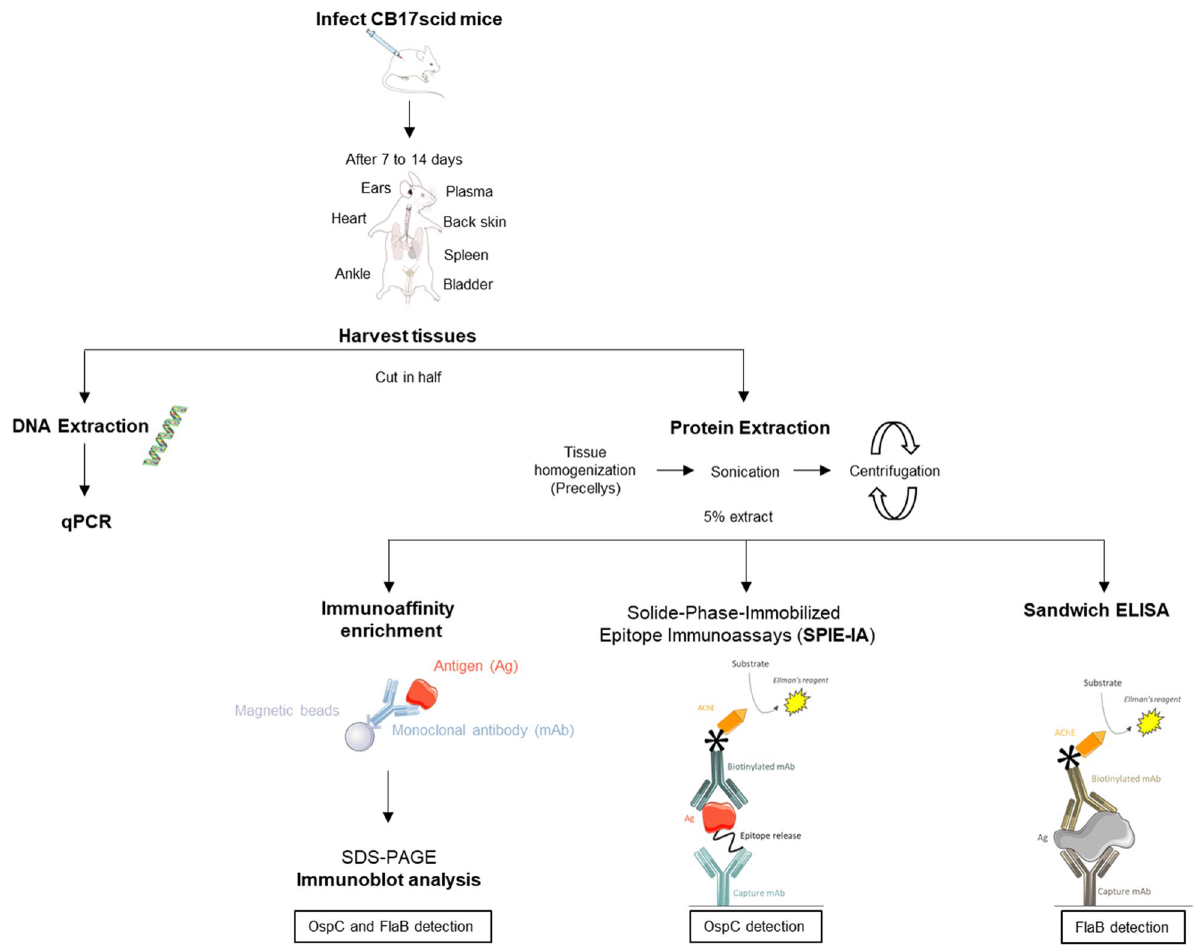
Figure 4. Data acquisition workflow. Schematic workflow employed for tissue analysis. After infection and sacrifice of the mice, the organs are collected for Borrelia quantification by qPCR and for protein analysis. Three methods are performed to detect OspC and FlaB markers: a duplex method for FlaB and OspC detection including an immuno-enrichment step before western blot analysis, a sandwich ELISA for FlaB detection, and SPIE-IA for OspC detection. This figure was created using images from Servier Medical Art (http:// smart. servi er. com/), licensed under a Creative Commons Attribution 3.0 License (CC BY 3.0 license: https:// creat ive. org/ licen ces/ by/3. 0/). The color of some images were modified. The mouse anatomy image is from Wikimedia Communs (https:// commo ns. wikim edia. org), licensed under a Creative Commons Attribution-share Alike